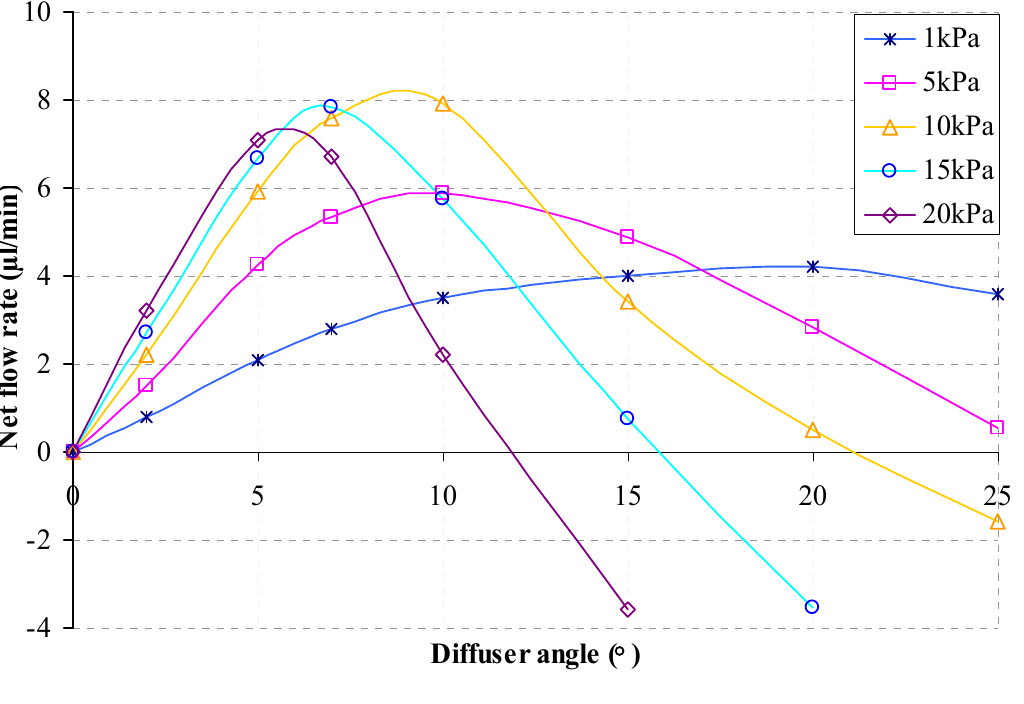
Figure 7. Efficiency ratio of the diffuser element for variation in Reynolds number at different diffuser angle ( AR =